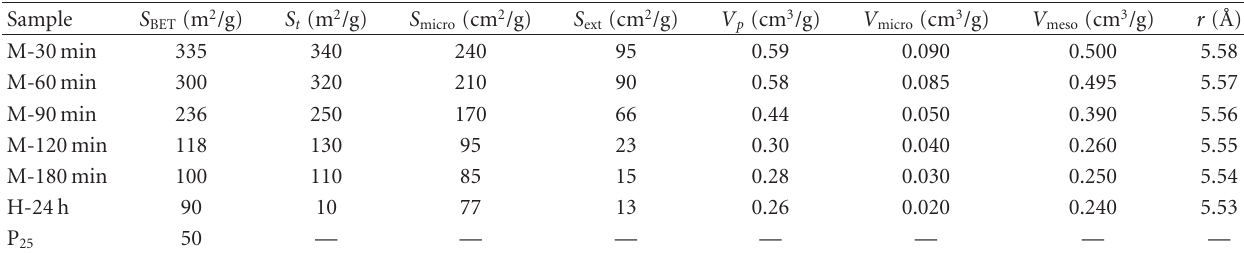
Table 2: Texture parameters of CeO 2 -SiO 2 samples.